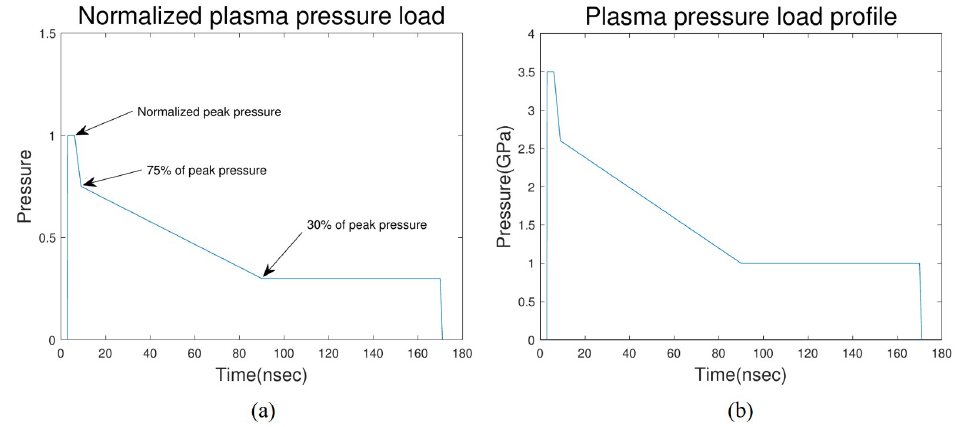
Figure 2. Pressure load profile; ( a ) Normalized pressure load profile adapted from [9,28]; ( b ) Plasma pressure load model induced by laser pulse, 4.2 J of pulse energy with pulse width of 10 ns.